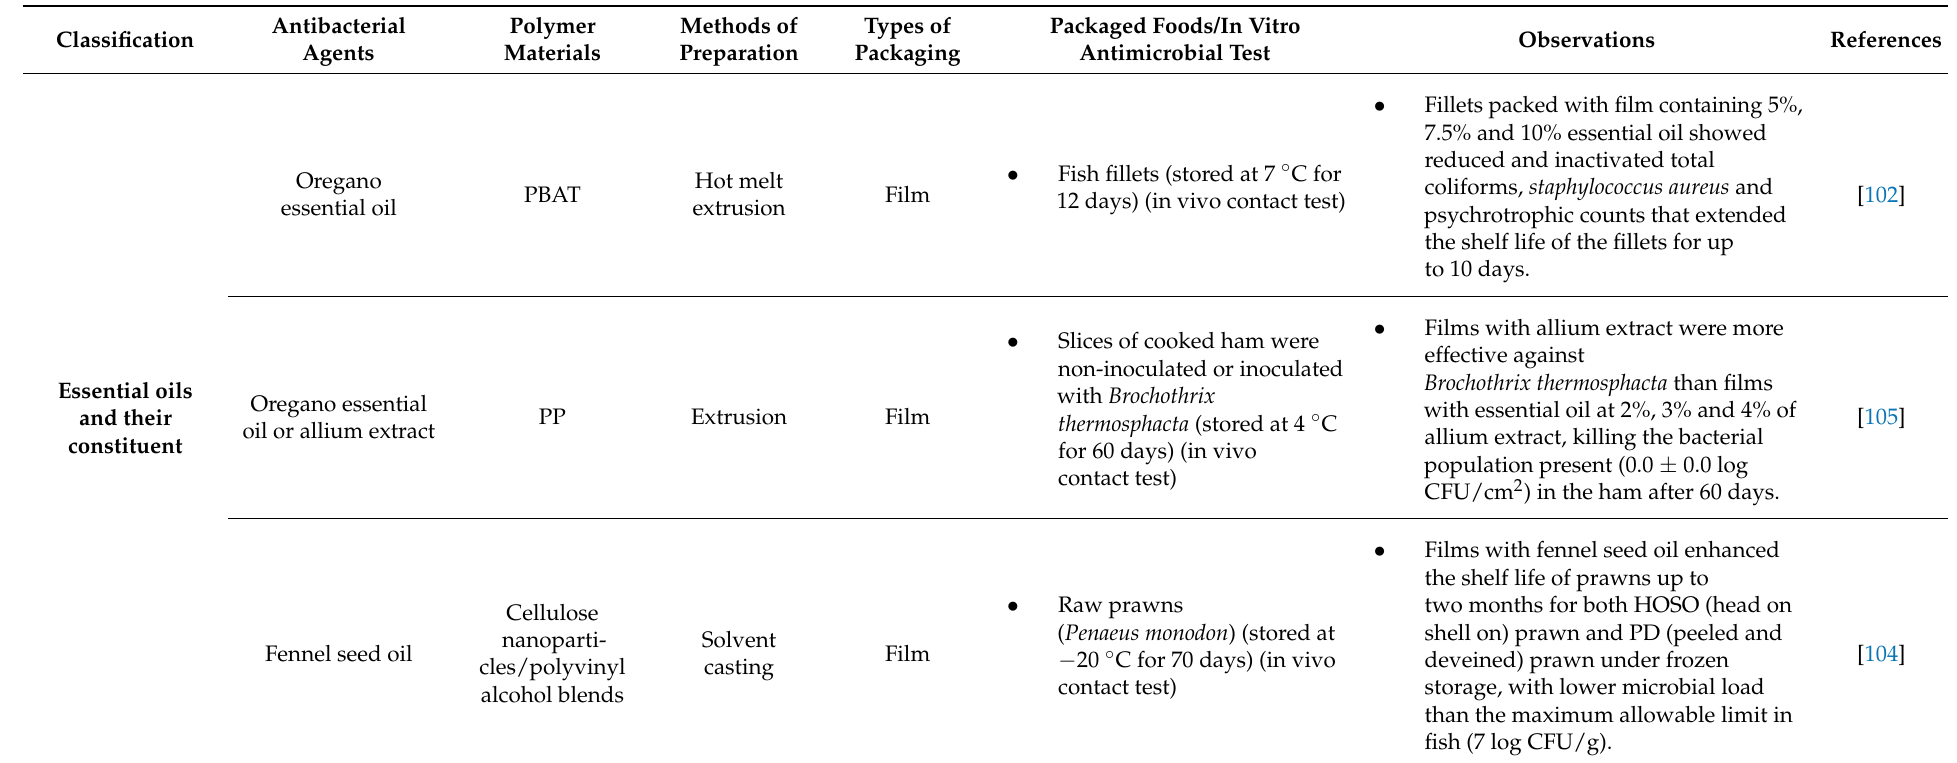
Table 2. Antibacterial packaging applications used in food